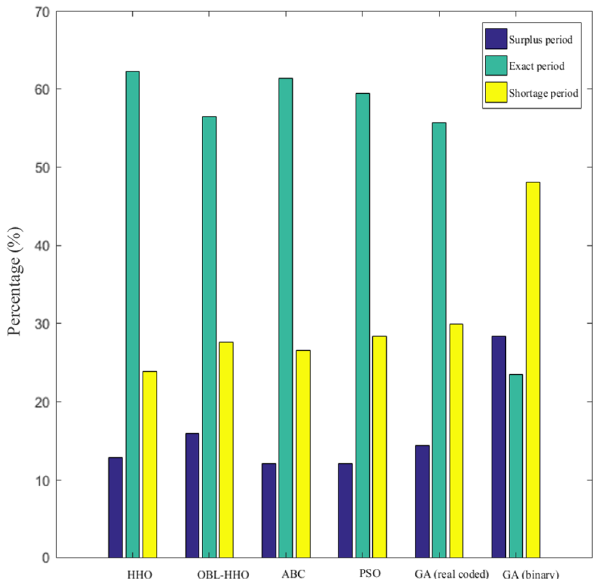
Figure 8. Monthly periodic reliability from year 1987 to